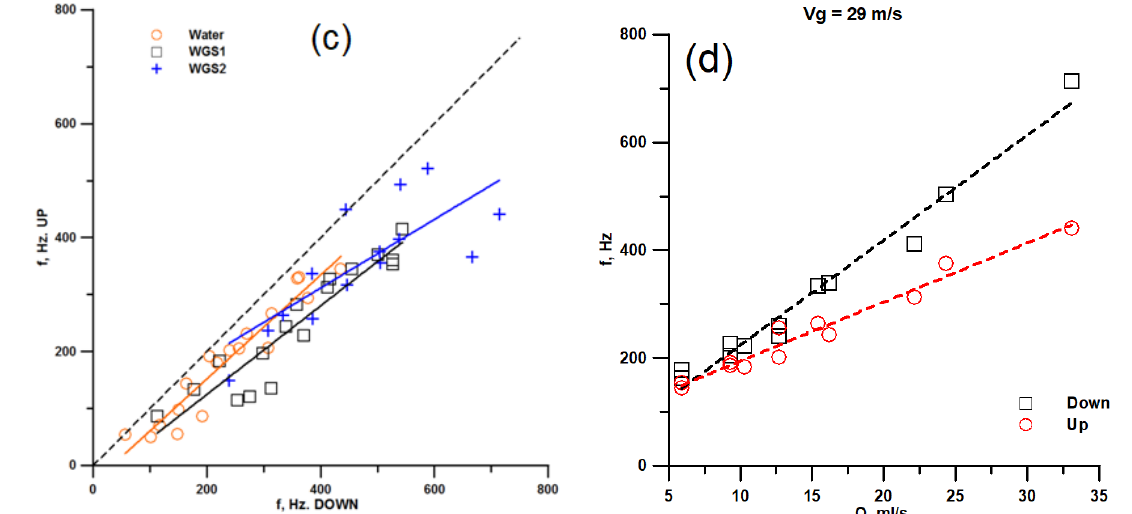
Figure 5. Frequency of the initial waves. ( a , b ) The effect of liquid viscosity at a fixed liquid flow rate for downward ( a ) and upward ( b ) flows. ( c ) The effect of flow orientation. ( d ) The effect of the liquid flow rate for a fixed gas velocity, V G = 29 m/s.